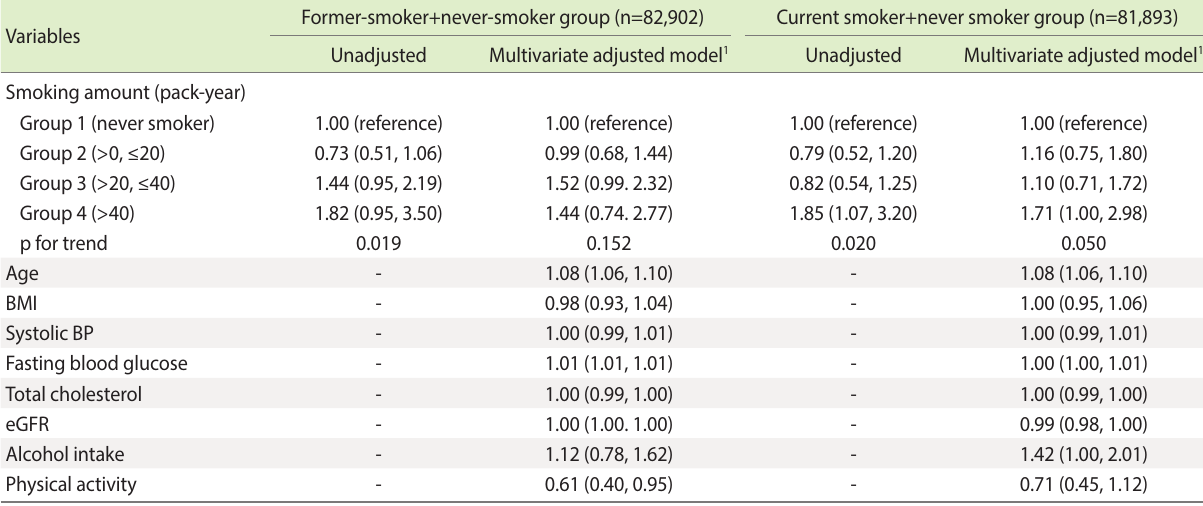
Table 3. The incidence of pancreatic cancer according to 4 smoking amount groups and smoking status subgroups